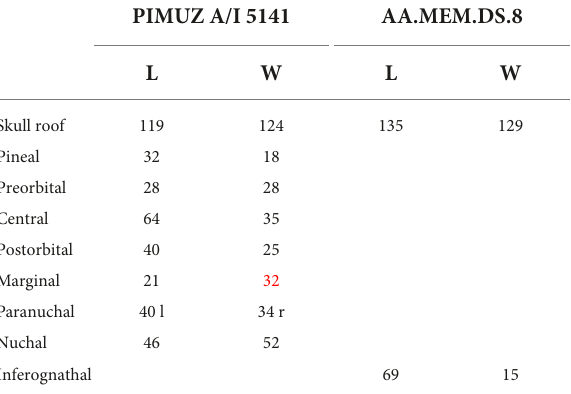
TABLE 1 Measurements of the skull roof of Amazichthys trinajsticae gen. et sp. nov. PIMUZ A/I 5141